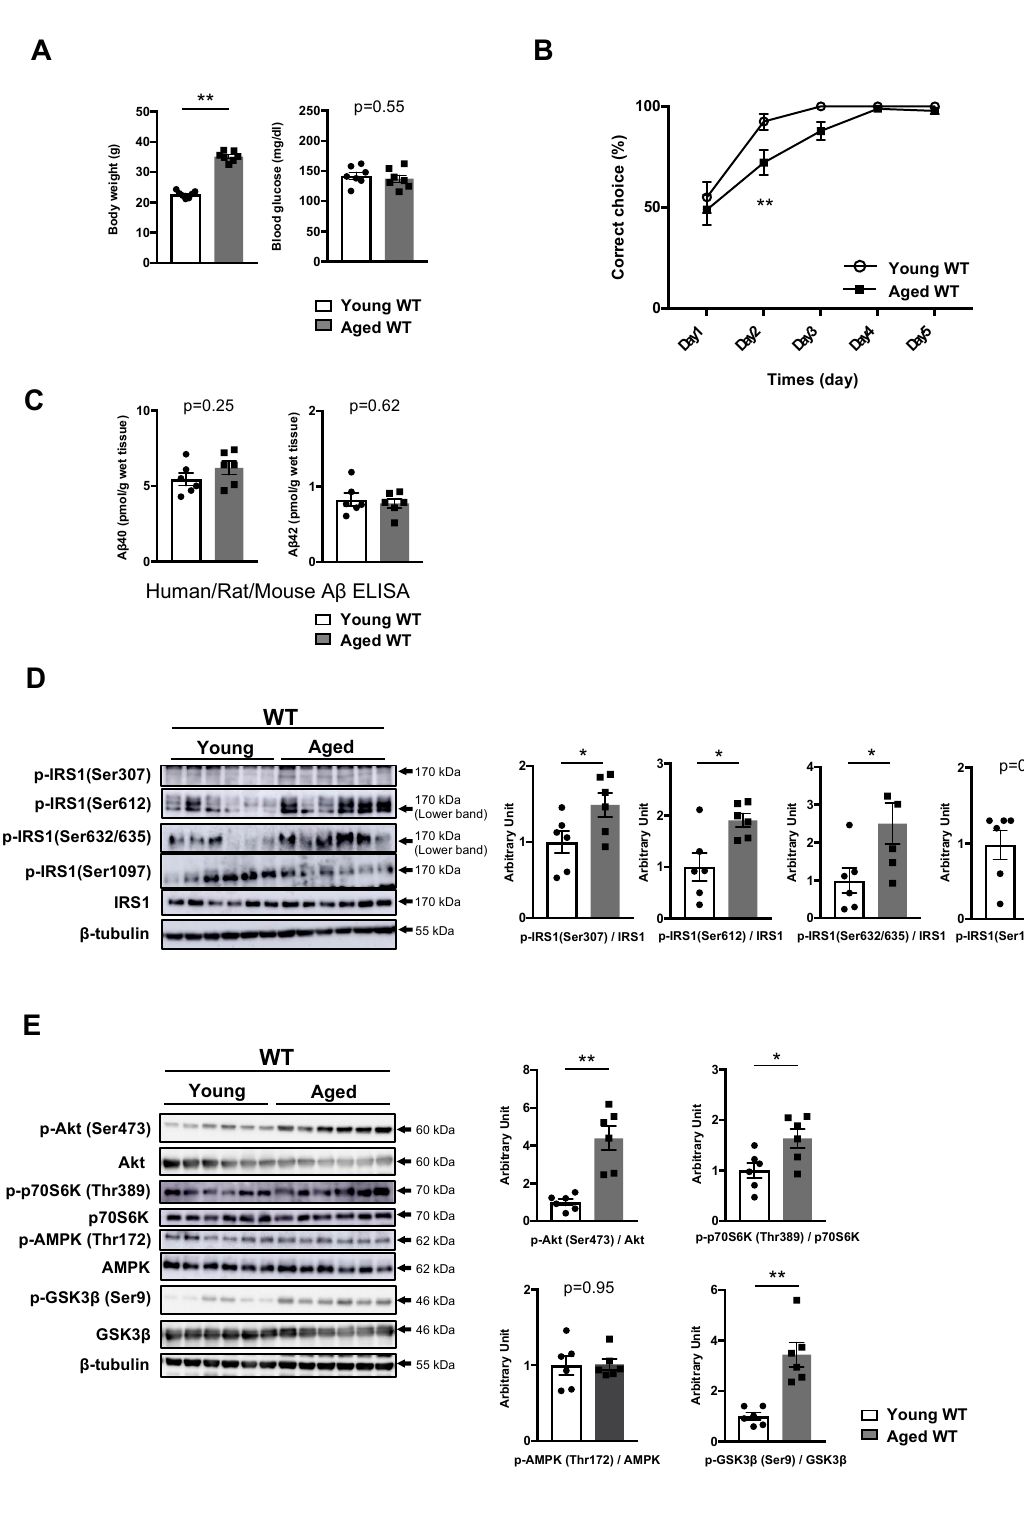
Figure 3. Age-related memory deficits accompanied by increased phosphorylation of IRS1 Ser sites in the hippocampus. ( A ) The graphs of body weight and blood glucose levels in young (12 weeks of age, n = 7 mice per group) and aged (84 weeks of age, n = 7 mice per group) wild-type (WT) mice. ( B ) Evaluation of learning memory functions in young WT mice (n = 16 mice per group) and aged WT mice (n = 18 mice per group) using the water T-maze test. ( C ) Quantitative analysis of T-PER- extractable A β 40 and A β 42 levels in the hippocampi of young (12 weeks of age, n = 6 biologically independent samples) and aged (84 weeks of age, n = 6 biologically independent samples) WT mice using the human/rat/mouse β amyloid (1 – 40 and 1 – 42) ELISA. ( D ) Western blot analysis of phosphorylated insulin receptor substrates 1 mouse Ser307 [p-IRS1 (mSer307)], p-IRS1 (mSer612),